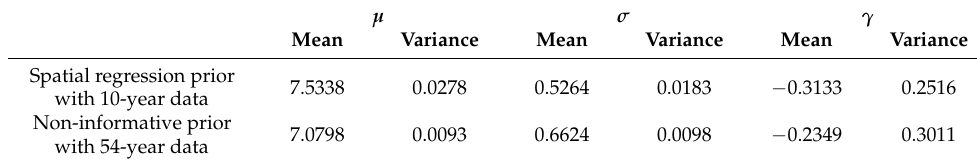
Table 6. Means and variances of the posterior